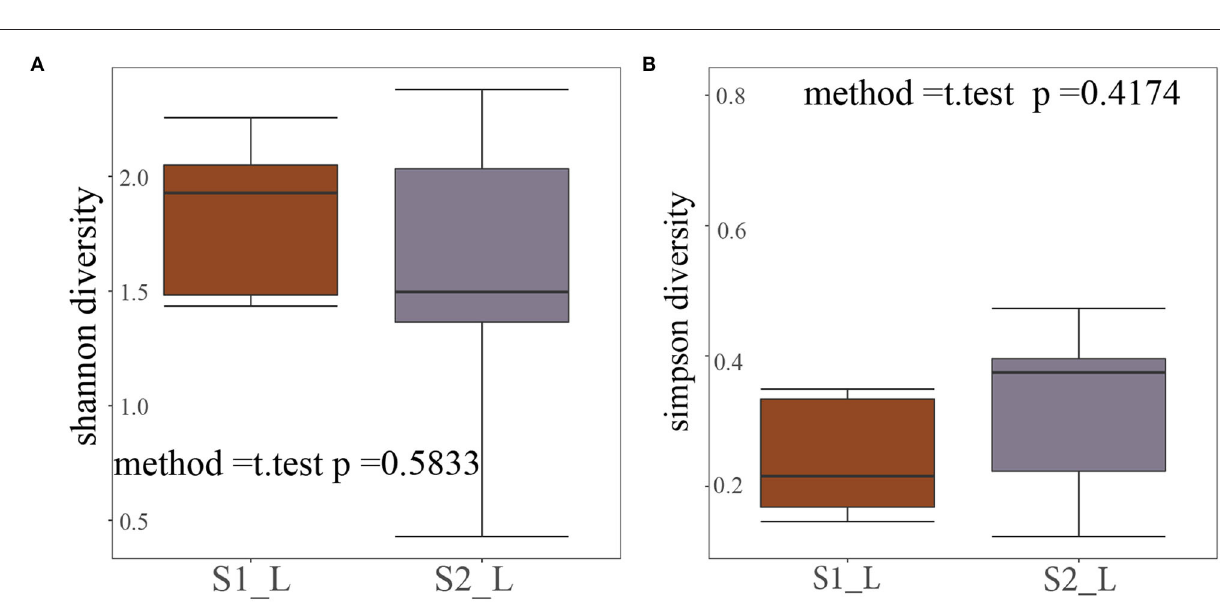
FIGURE 4 | Microbe diversity. (A) Shannon alpha diversity. (B) Simpson alpha